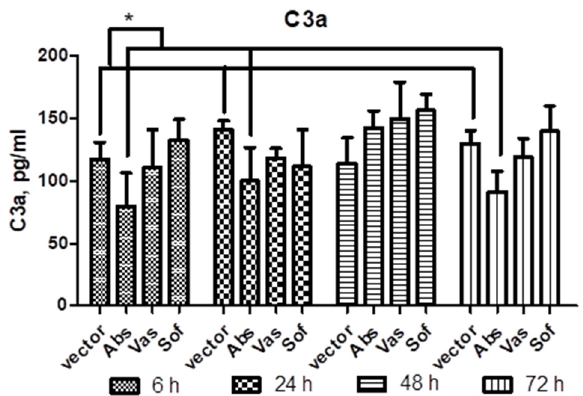
Figure 4. C3a in sera of mice after injection of NS1 genes of strains of three subtypes. Plasmids encoding NS1 of Absettarov (Abs), Vasilchenko (Vas) and Sofjin-Chumakov (Sof) strains or pVax vector (vector) were intramuscularly injected into BALB/c mice and levels of C3a in sera were measured by ELISA. Each bar represents the mean value with SD of three pools of 4–5 mice sera that were run in duplicate. Statistically significant differences (* p < 0.05) derived by the Student’s t -test of individual strains as compared to vector are labeled.